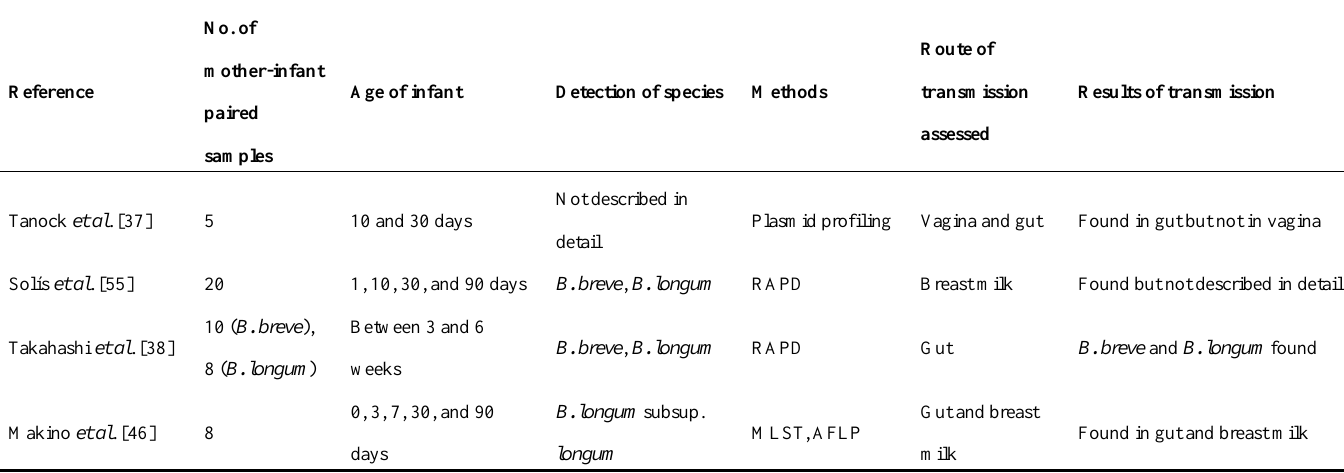
Table 1. Studies on the transmission of bifidobacterial strains from pregnant women to their infant’s